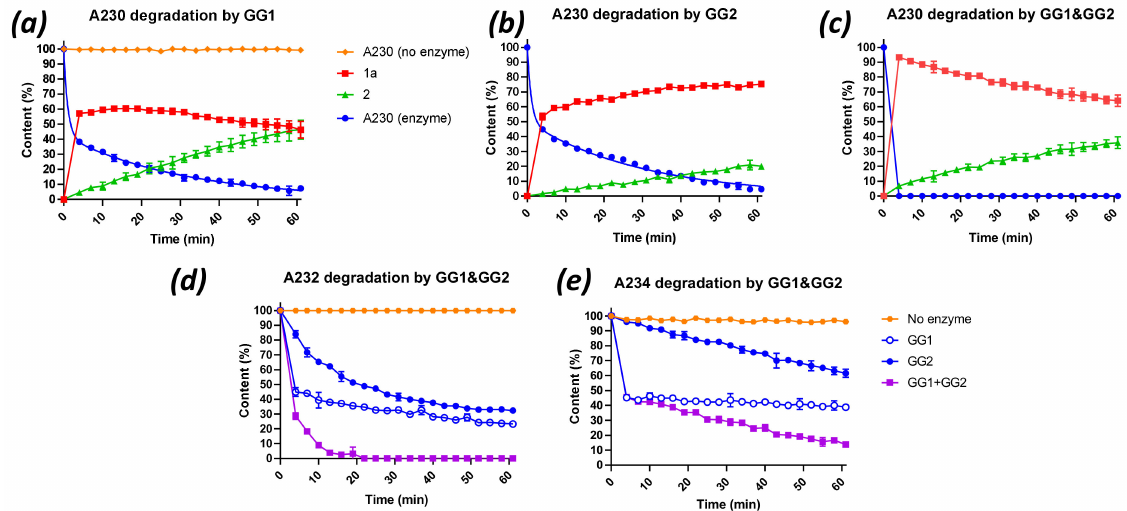
Figure 2. Degradation curves of Novichok agents A230, A232 and A234 by GG1 and GG2 enzymes. Degradation of A230 by GG1 ( a ) and GG2 ( b ) or both ( c ). Red and green represent the products of A230 hydrolysis. Degradation of A232 ( d ) and A234 ( e ) by GG1, GG2 or both. Agent concentration: 25 mM, enzyme concentration; 20 µ M (for GG1 and GG2 mix, 1:1 ratio). Experiments were conducted in 100–200 mM Tris buffer pH 9, 50 mM NaCl at 23 ◦